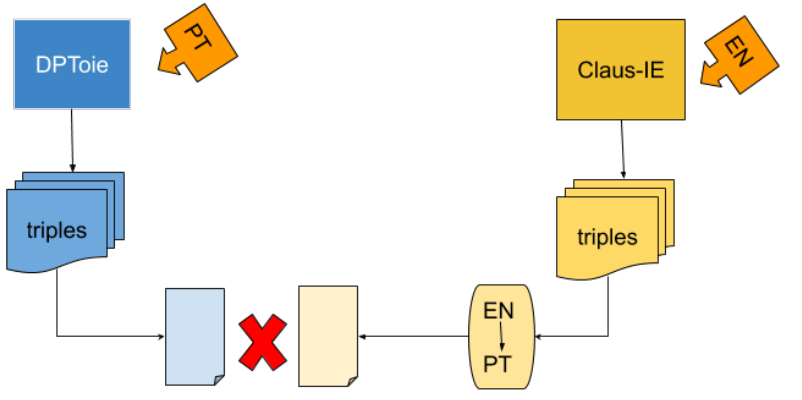
Figure 15. Experiment on relation extractions intersection for two languages: Portuguese (PT) and English (EN). (Authors’